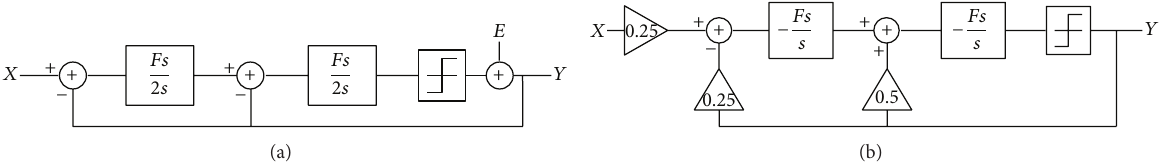
Figure 3: ADC system diagram before (a) and after (b) parameter scaling.